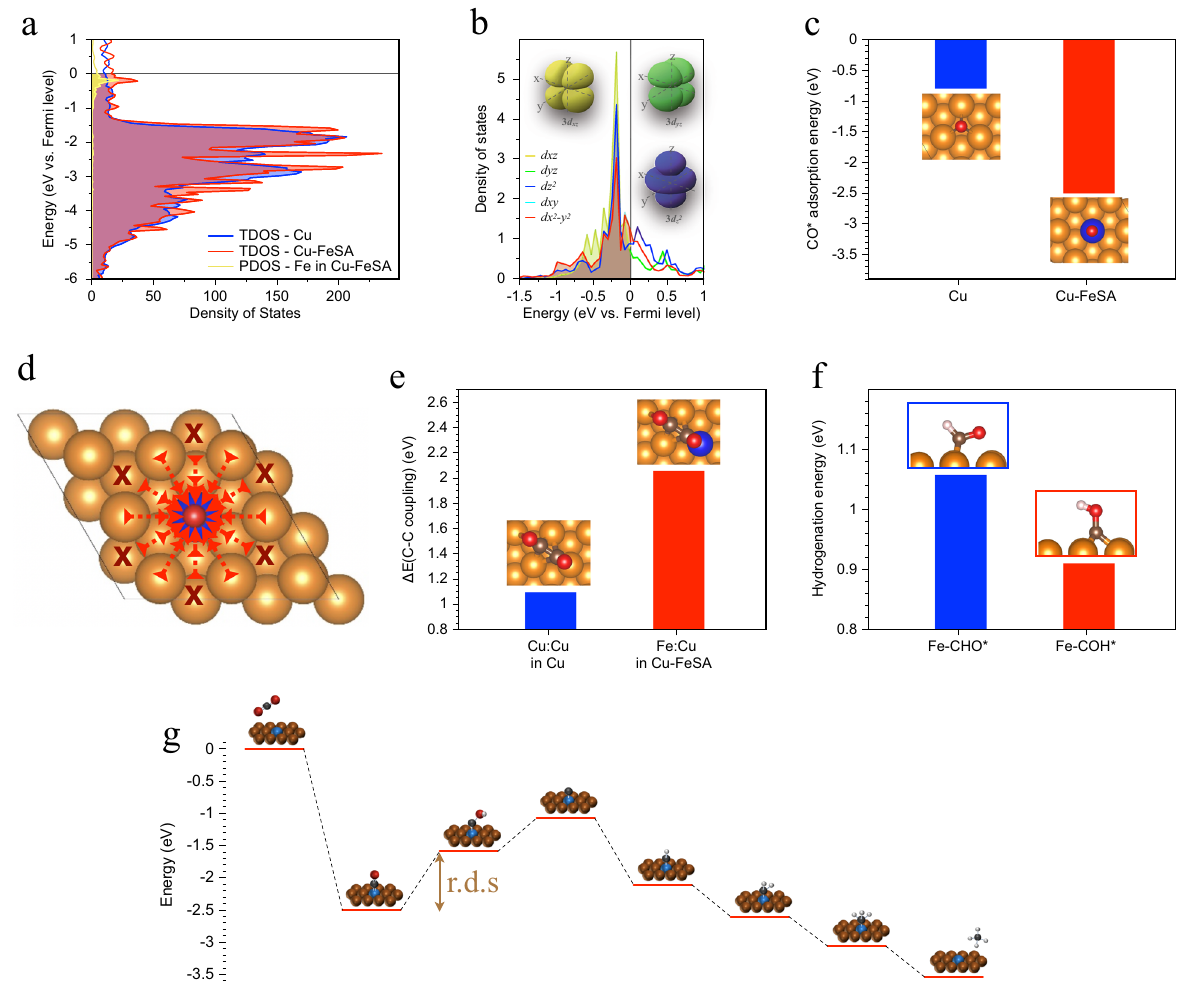
Fig. 2 Mechanism study for the copper-supported single-atom iron catalyst. a Density of states of pristine Cu and Cu-FeSA. b Adsorption energy of *CO for pristine Cu and Cu-FeSA. c Deconvolution of d orbitals of single-atom iron in Cu-FeSA. d Schematic illustration of *CO transition: the arrow heads mean the transition pathway while the cross marks suggest immobile *CO adsorption sites. e C-C coupling energy for pristine Cu vs. Cu-FeSA. f Hydrogenation energy of the intermediates for methane production on the iron sites in Cu-FeSA. g Energy diagram for methane evolution in Cu-FeSA. The r.d.s. (rate determining step) is the hydrogenation of *CO intermediates on the iron